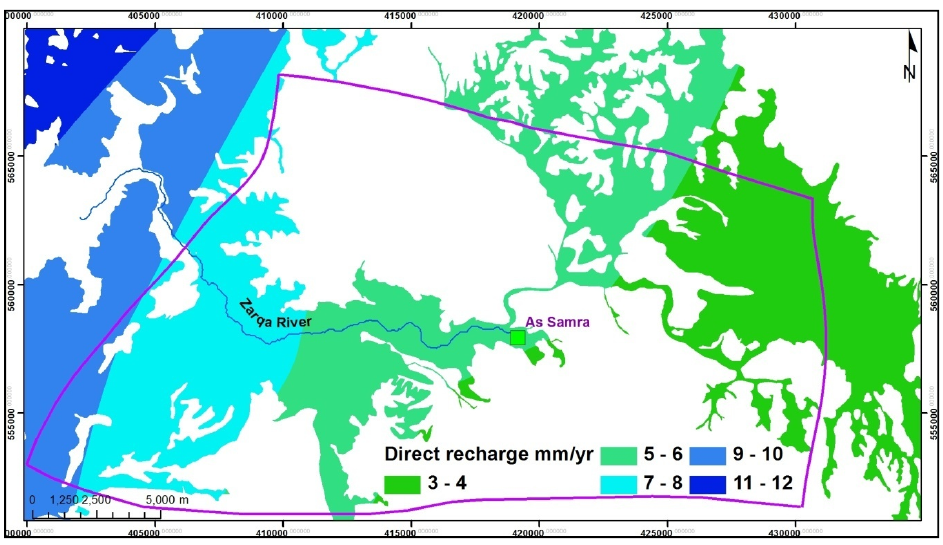
Figure 3. Recharge in the study area.